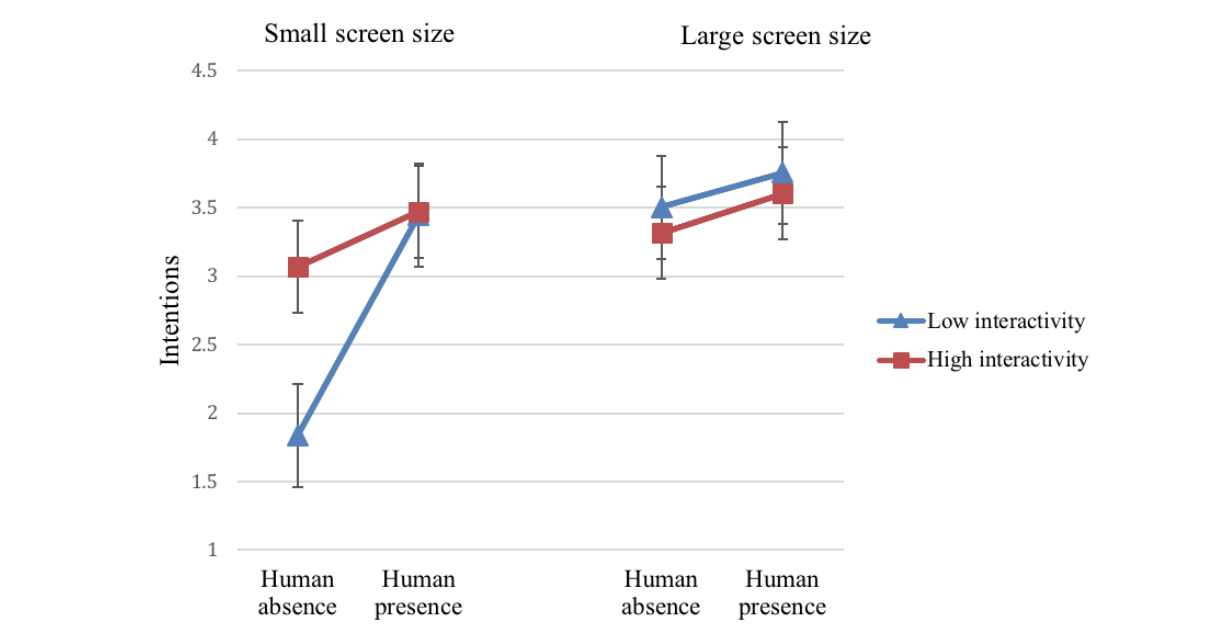
Figure 6. Three-way interaction of screen size, interactivity, and human presence on